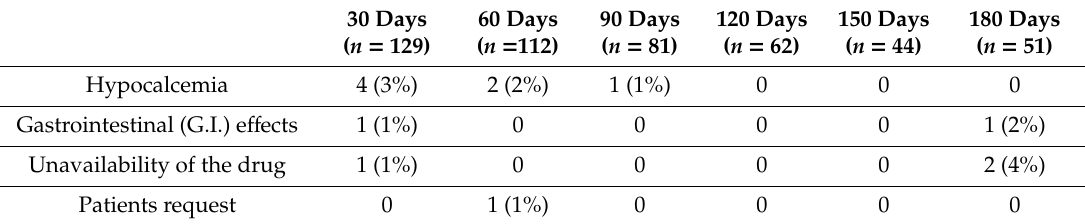
Table 3. Cause of discontinued treatment with